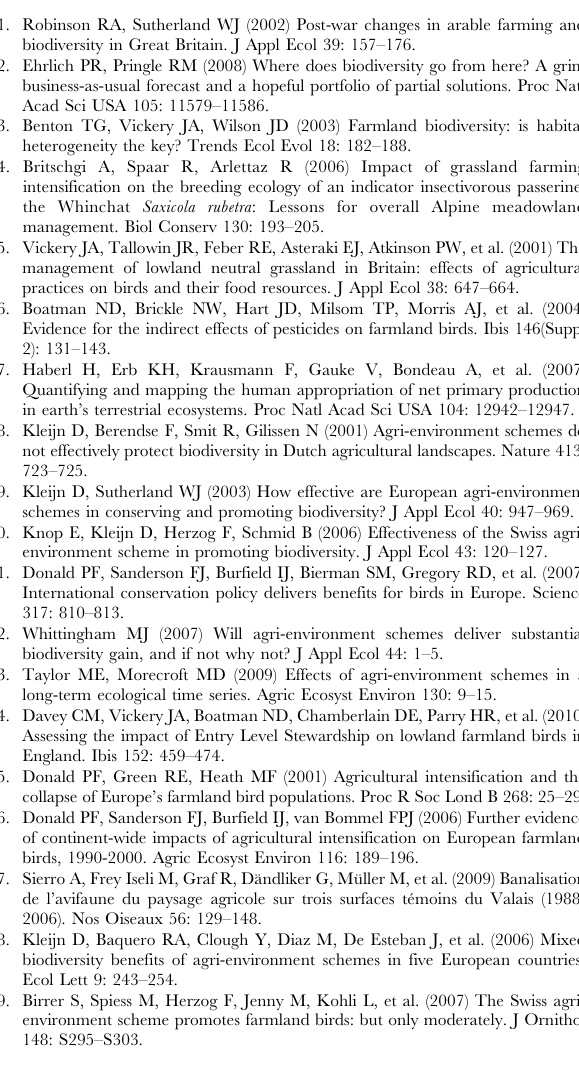
Table S2 Estimates of the mean model parameters and of their variability among individuals from the most complex model (b + b2 + h + h2) for each species. Values in parentheses show the limits of the 80% credible intervals for each